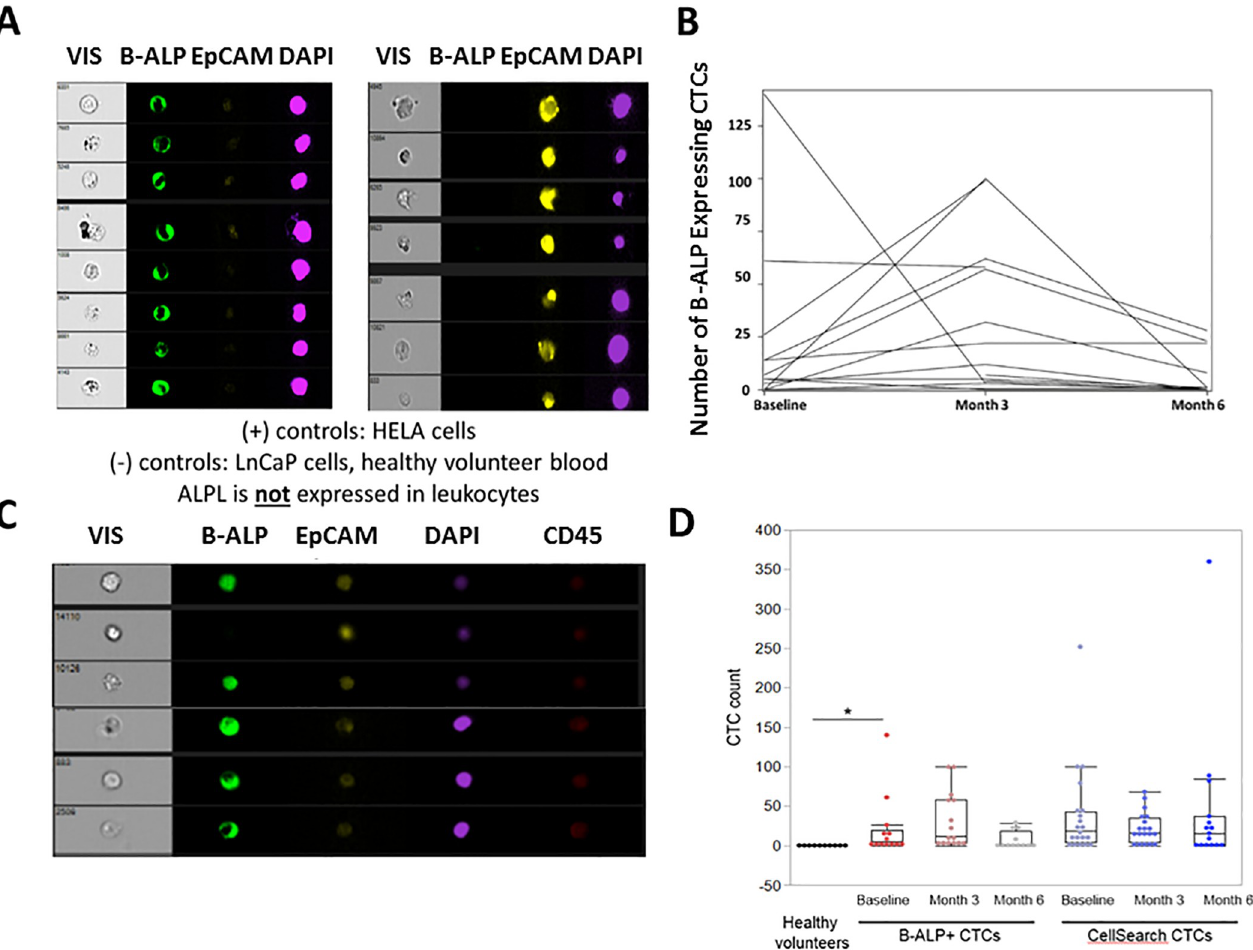
Fig 3. Immunofluorescent micrographs of CTCs expressing bone alkaline phosphatase (B-ALP, or BAP), Epithelial cell adhesion molecular (EpCAM), DAPI, and CD45. A . Expression of B-ALP and EpCAM in negative and positive control cell lines spiked into healthy volunteer blood. HELA cells positive for B-ALP (Green) and negative for EpCAM (Yellow) are shown on the left and T47D cells negative for B-ALP and positive for EpCAM are shown on the right. B. Changes in CTC B-ALP expression over time during radium-223 therapy. C. Examples of CTCs from men with bone metastatic CRPC treated with radium- 223, demonstrating heterogeneity of CTC B-ALP expression in CTCs including in EpCAM negative CTCs. D. Plots of B-ALP (+) CTCs in healthy volunteers (n = 10) and patients (n = 20) over time, as well as Cellsearch CTCs (n = 20) from patients over time during radium-223 therapy (baseline, month 3 and month 6). � p = 0.0053 for difference in B-ALP (+) CTCs between healthy volunteers and mCRPC patients by non-parametric Kruskal-Wallis test.